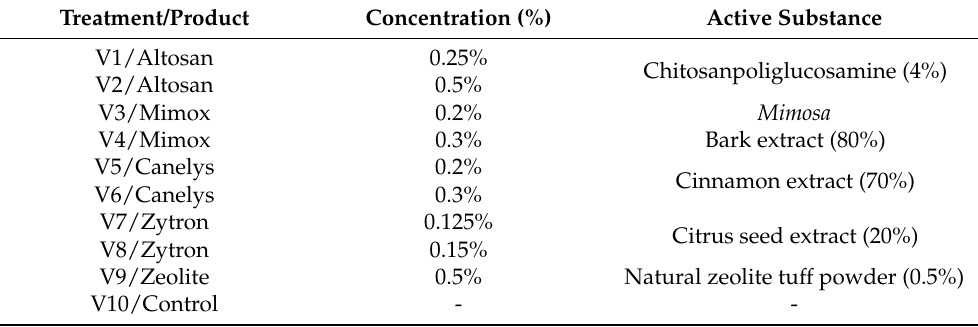
Table 12. Natural products-based treatments applied to the blackberry and raspberry varieties investigated in this study during